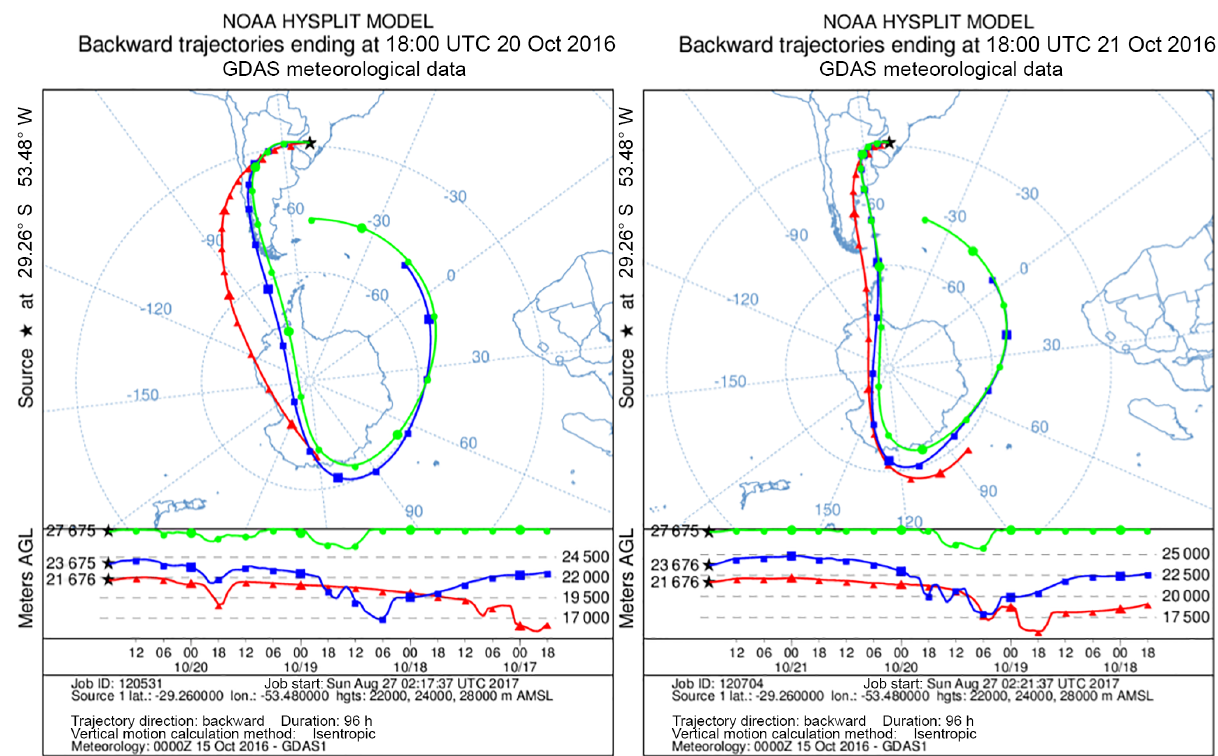
Figure 1. Backward trajectories from NOAA’s HYSPLIT model. The trajectories are shown according to height levels: 28 (green), 24 (blue), and 22km (red). Source: obtained using command lines at HYSPLIT/NOAA